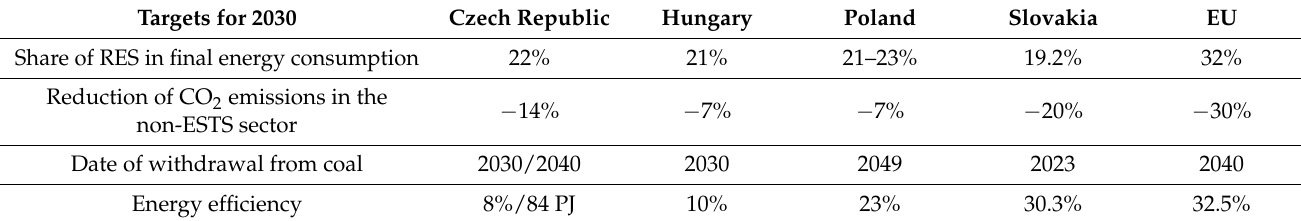
Table 2. Energy transformation goals for 2030 in V4 countries, [14,20,39,43–45]. Targets for